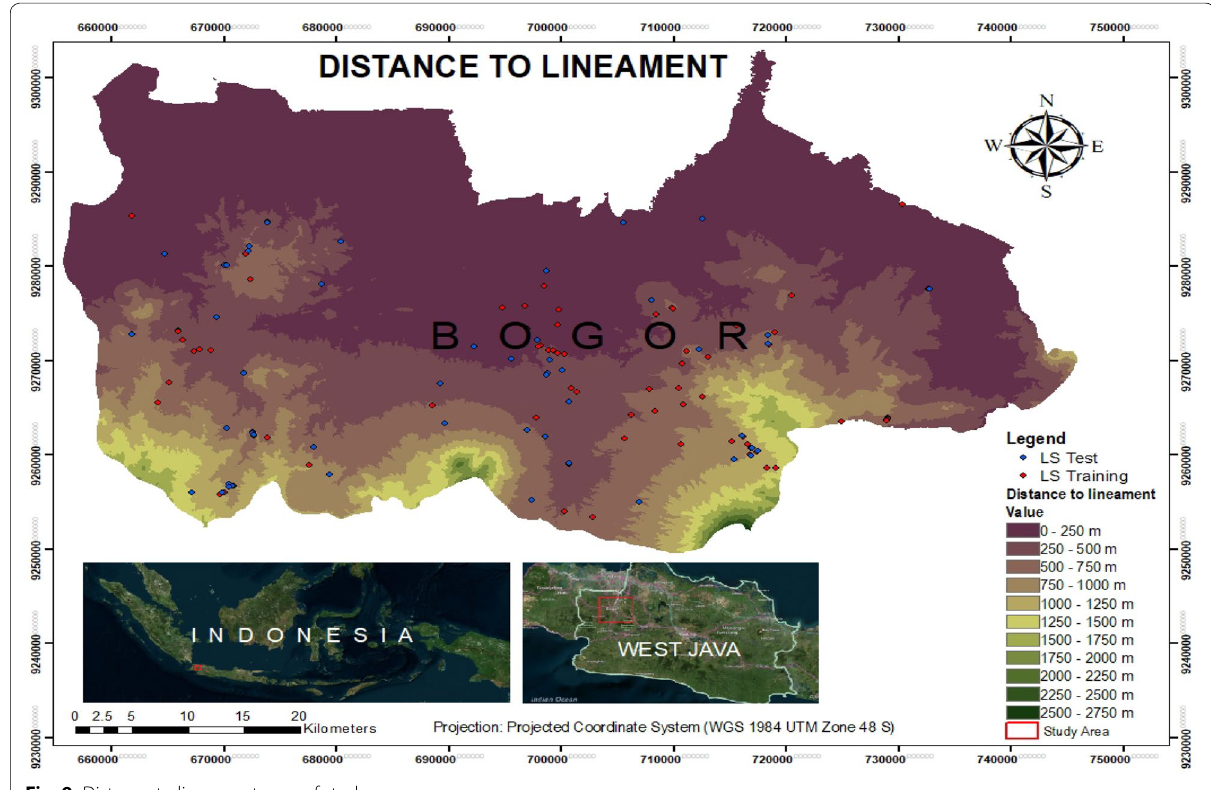
Fig. 9 Distance to lineament map of study